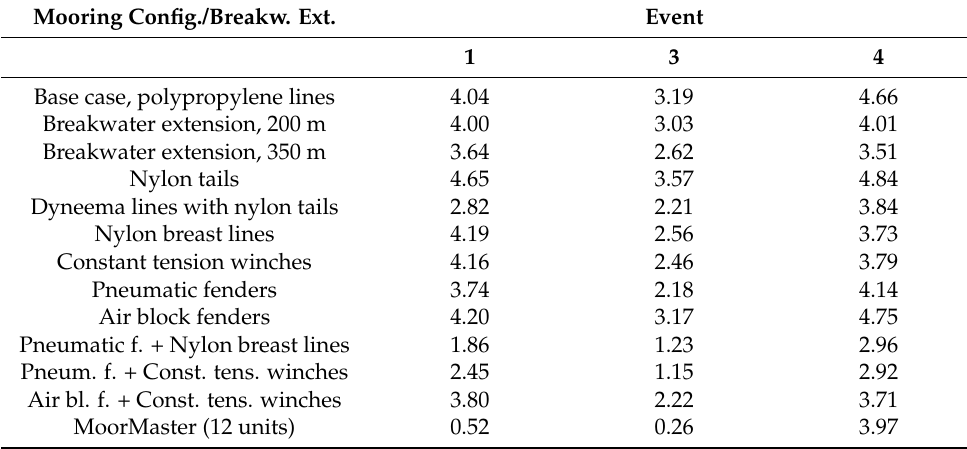
Table 7. Maximum surge motions